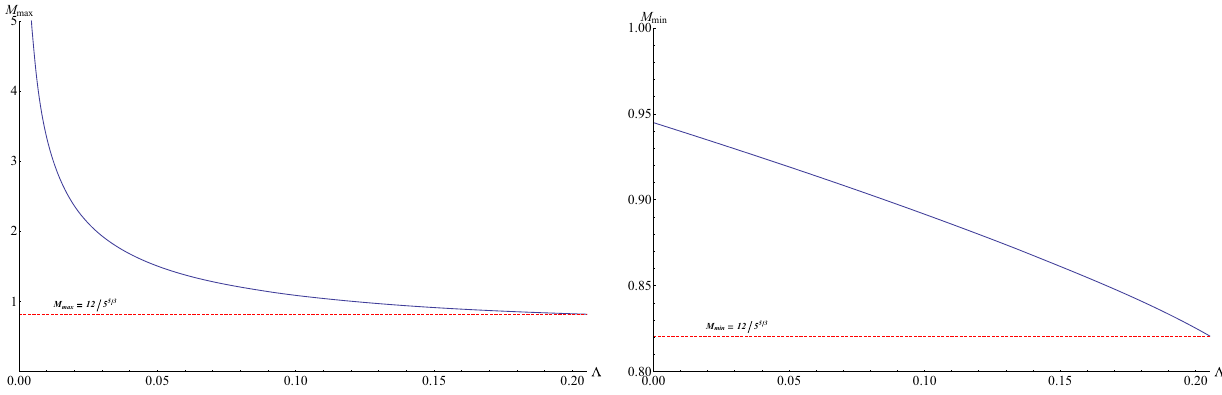
Fig. 3 We plot the mass of the Nariai black hole (left) and that of the cold black hole (right) in terms of the cosmological constant, at the magnetic charge Q = 1